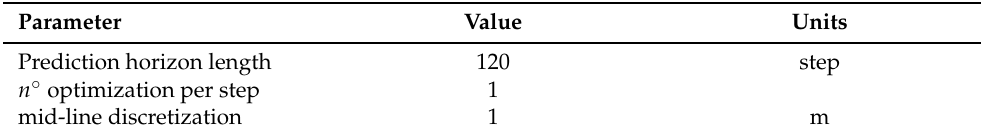
Table 3. Optimization algorithm